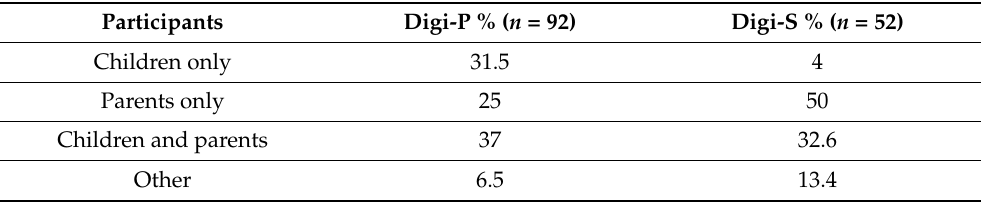
Table 2. Participant groups as % of the Digi-P and Digi-S